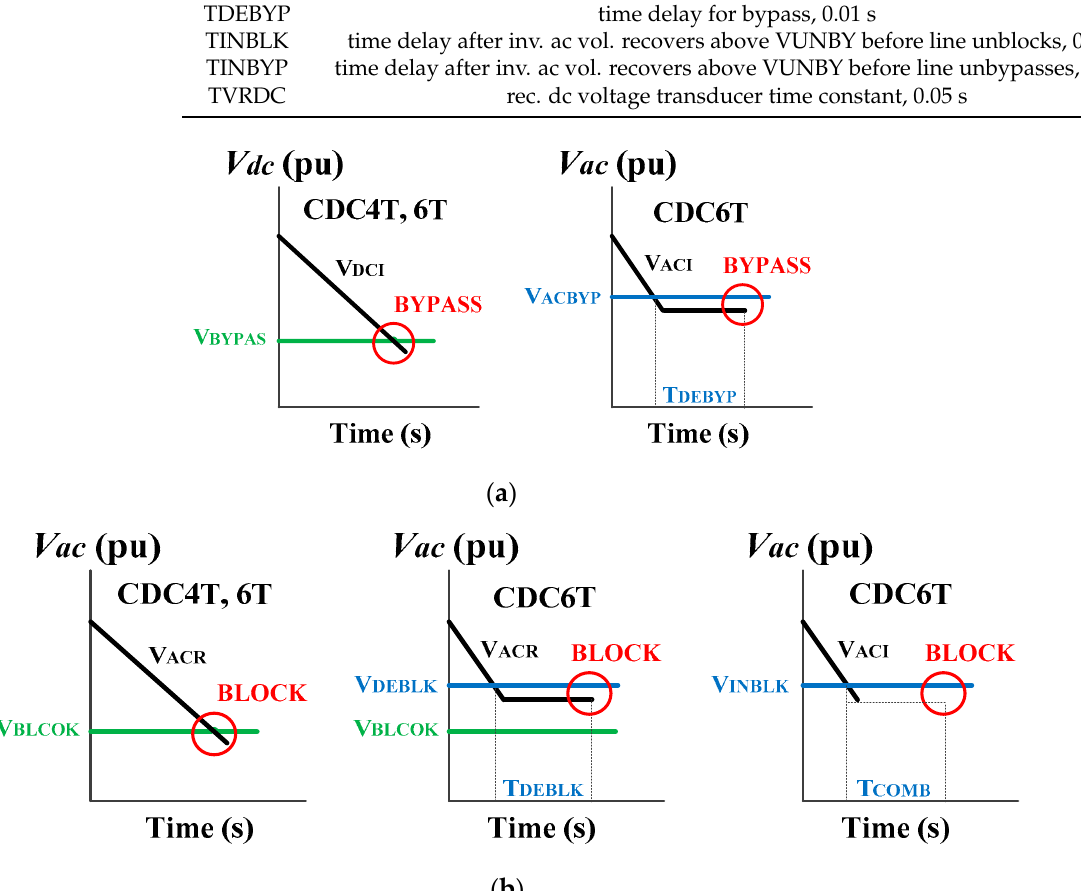
Figure 2. Differences of protection functions between the CDC4T and CDC6T: ( a ) bypass; ( b ) block.